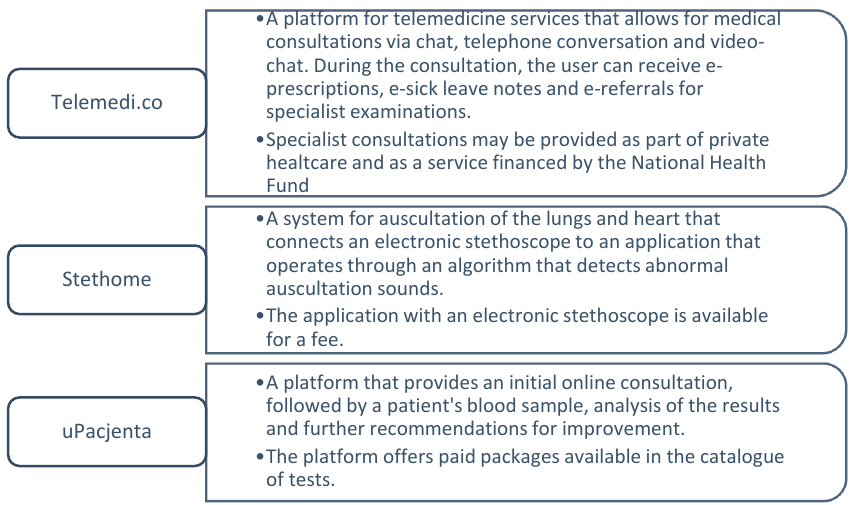
Figure 10. Examples of Polish startups as successfully implemented telemedicine solutions [53].